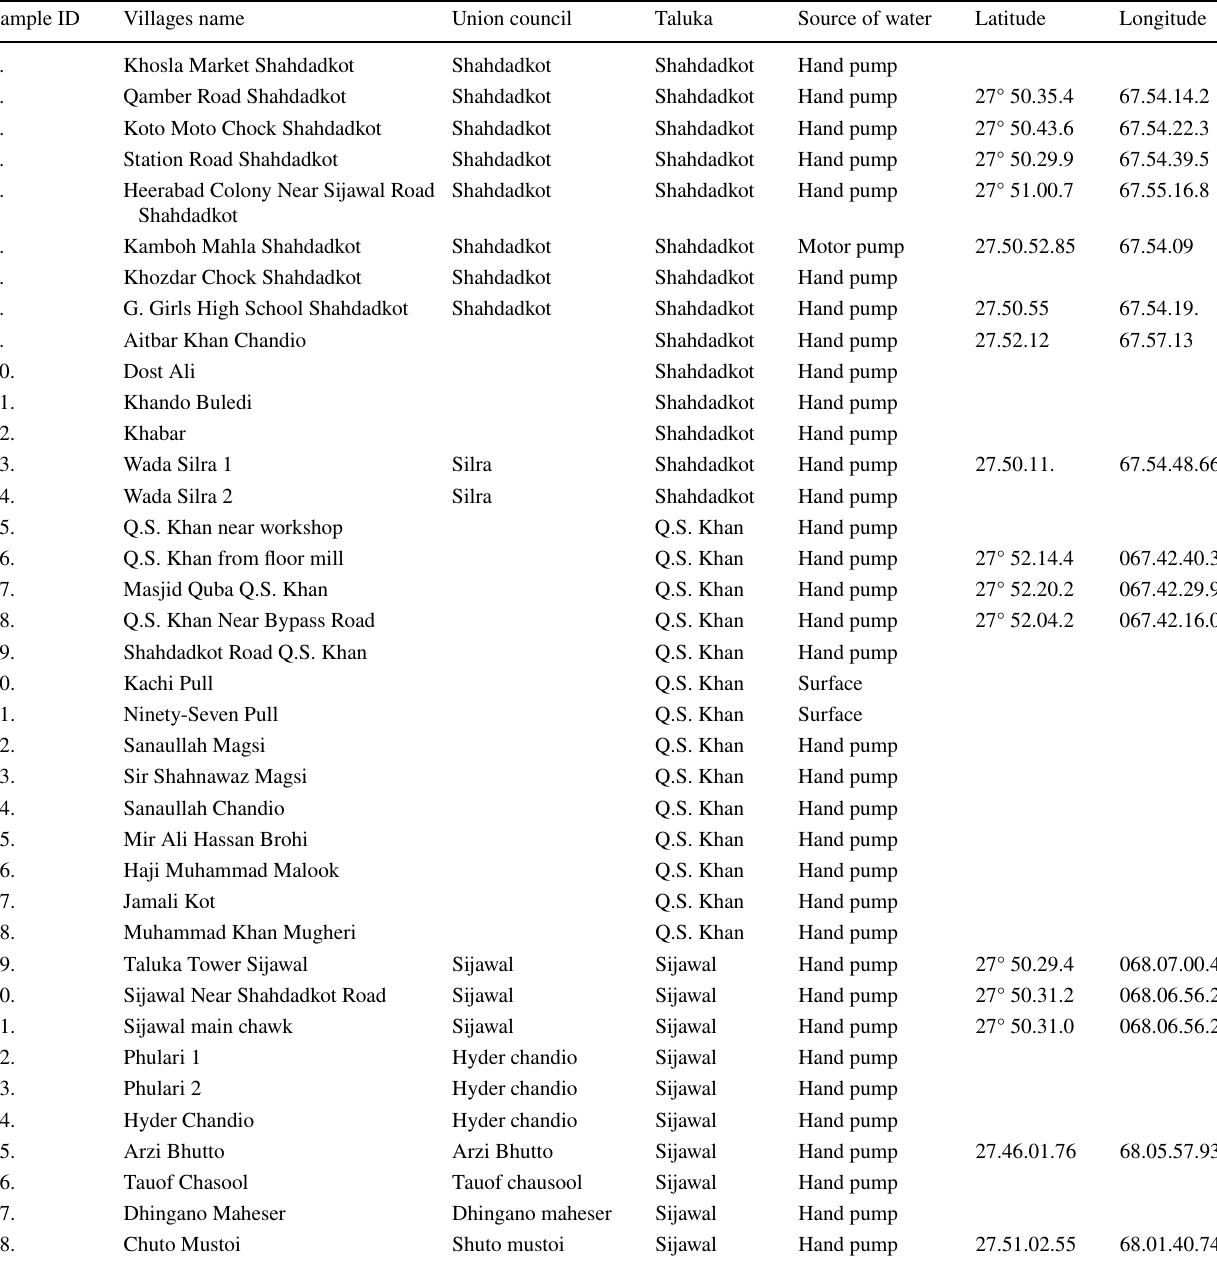
Table 1 Name of sampling towns and villages of three talukas of district Qambar Shahdadkot Sample ID Villages